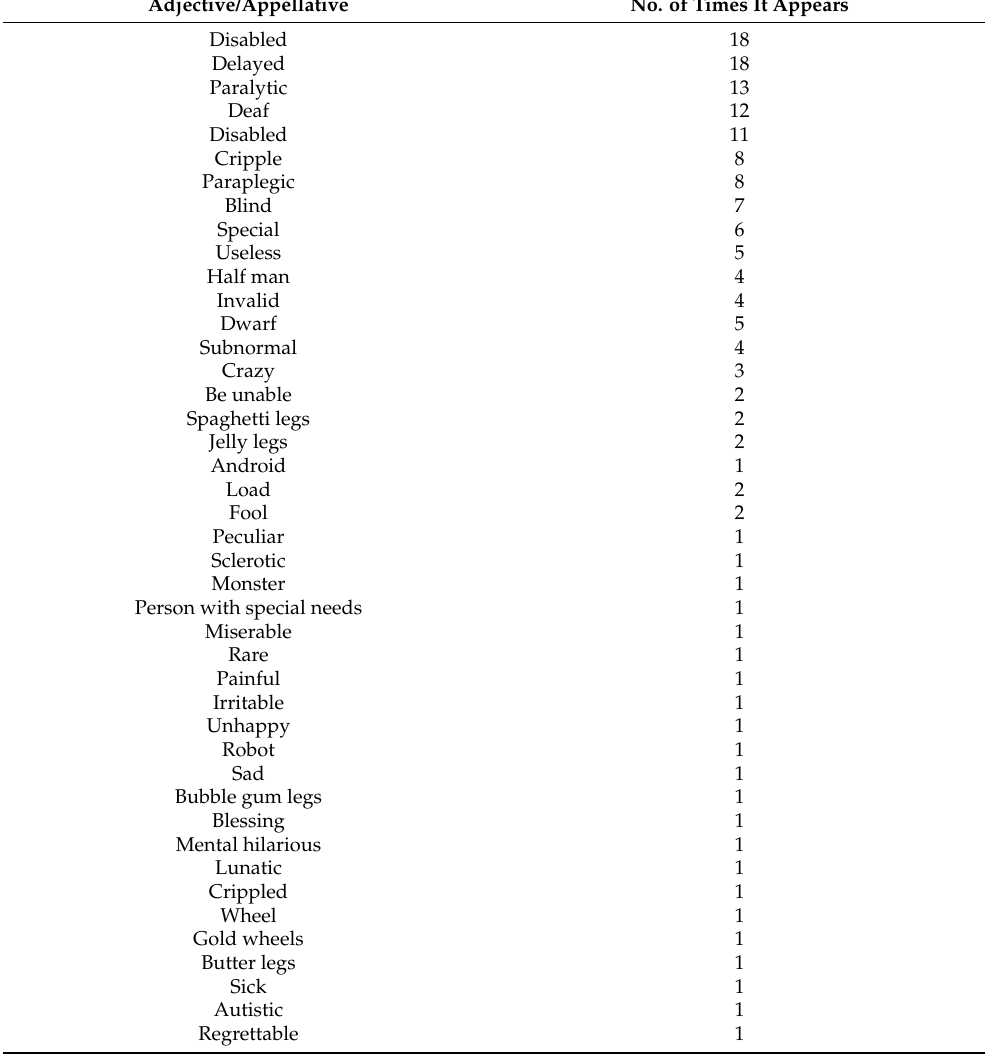
Table 2. Concepts used for persons with